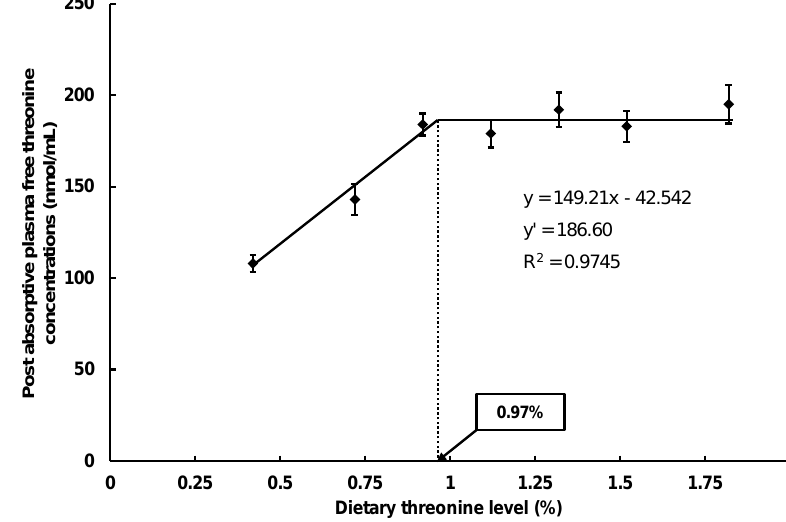
Figure 2. Broken line analysis of post-absorptive plasma threonine concentrations (nmol/mL) in rainbow trout fed graded levels of dietary threonine. Values of the X-axis are the threonine levels in the experimental diets. Values are means±standard deviation of 5 replicates. Y = 149.21x–42.542, Y ' = 186.6, R 2 =